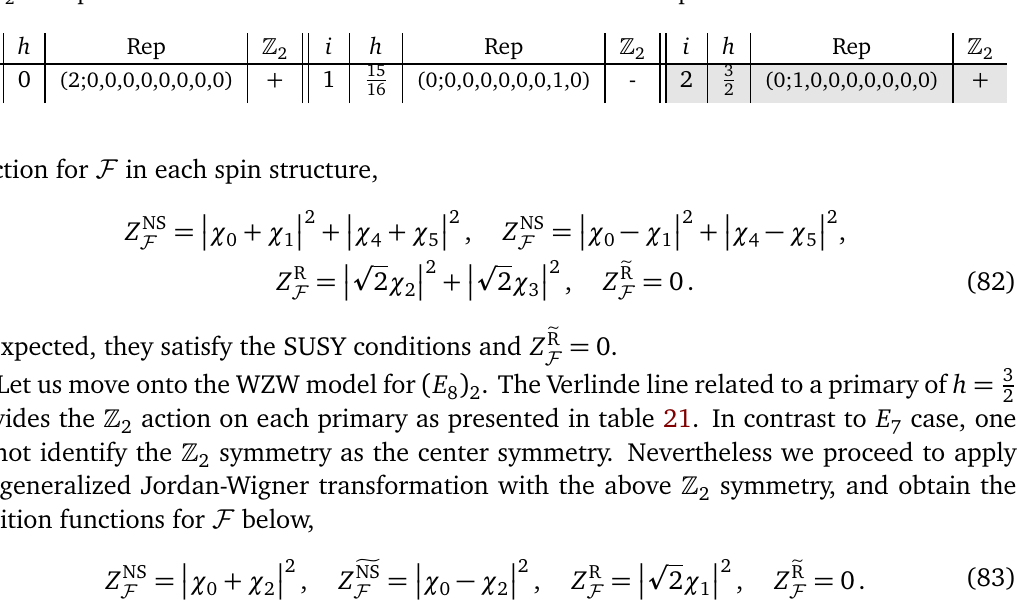
Dynkin labels. 8